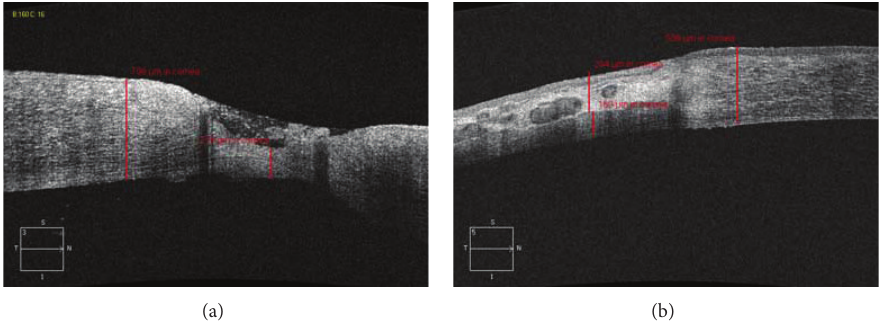
Figure 3: (a) The preoperative AS-OCT showed that the ulcer involved two-thirds of the depth of the corneal stroma. (b) The conjunctival flap healed the cornea tissue, appearing semitransparent and highly